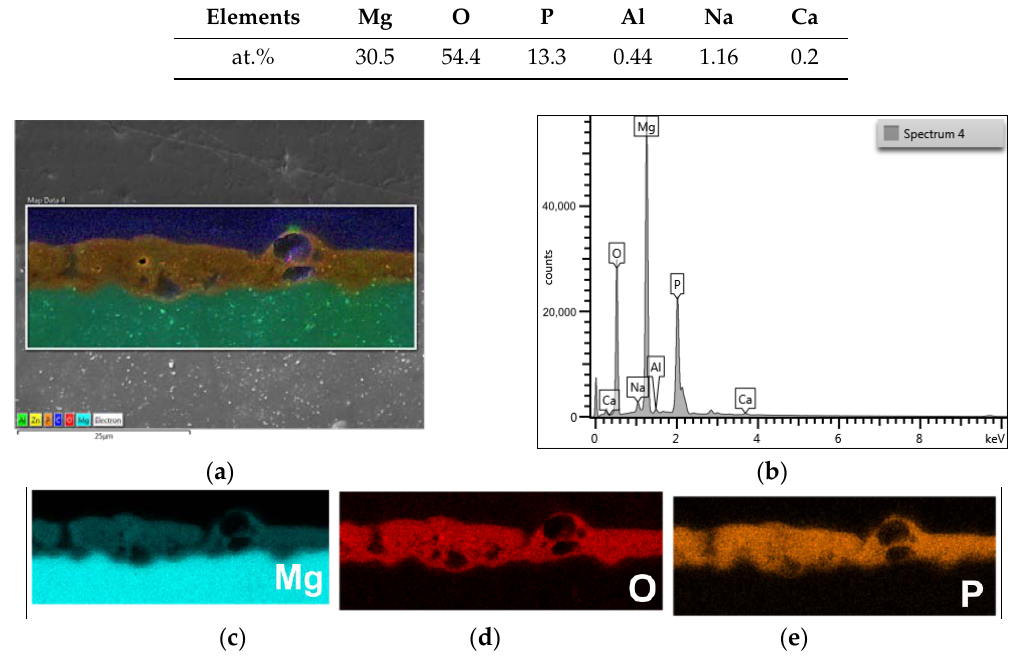
Figure 12. EDX mapping ( a ), EDX spectra ( b ) and distribution of Mg ( c ), O ( d ) and P ( e ) of PEO coating fabricated on AZ31 alloy in the electrolyte containing 12 g/ L of Na 3 PO 4 ∙12 H 2 O.